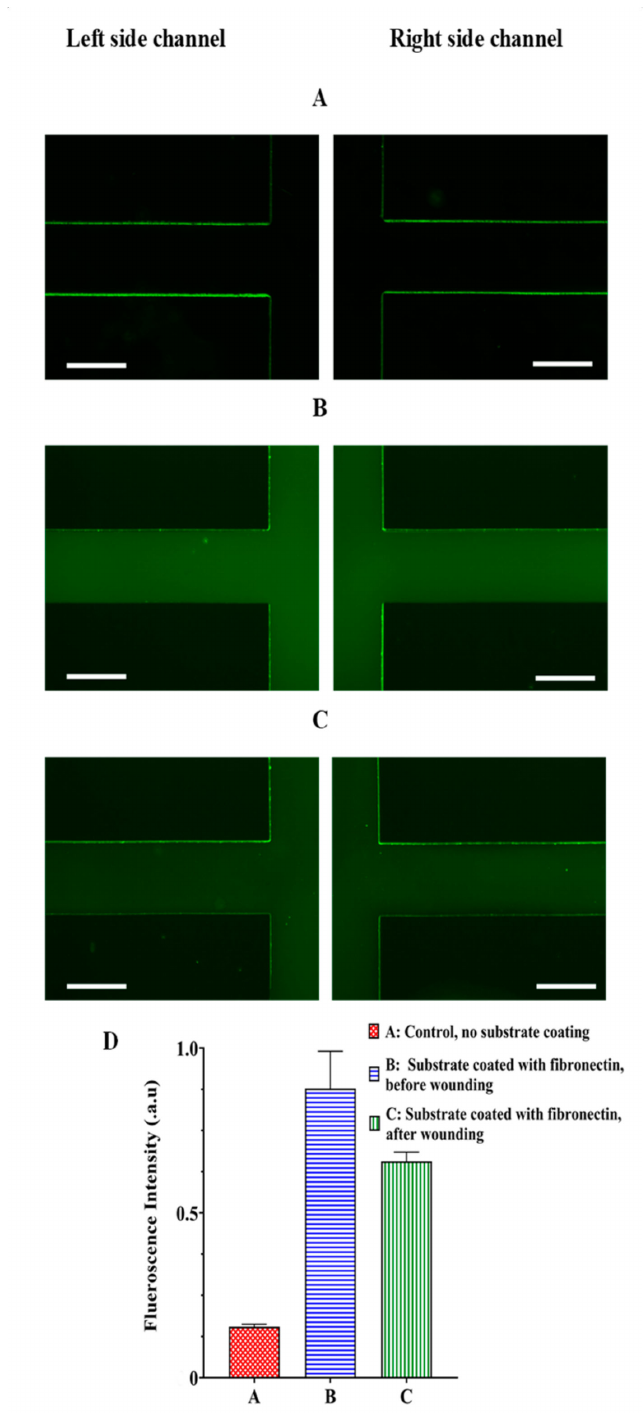
Figure 4. Fluorescence images from the device ( A ) glass substrate without coating (the control condition), ( B ) glass substrate coated with fibronectin before performing the process of the cell-free area creation (no flowing within the device), and ( C ) glass substrate coated with fibronectin after generating the cell-free area. ( D ) Quantification of the fluorescence intensity in the side channels in cases A, B and C, scale bar = 600 µ